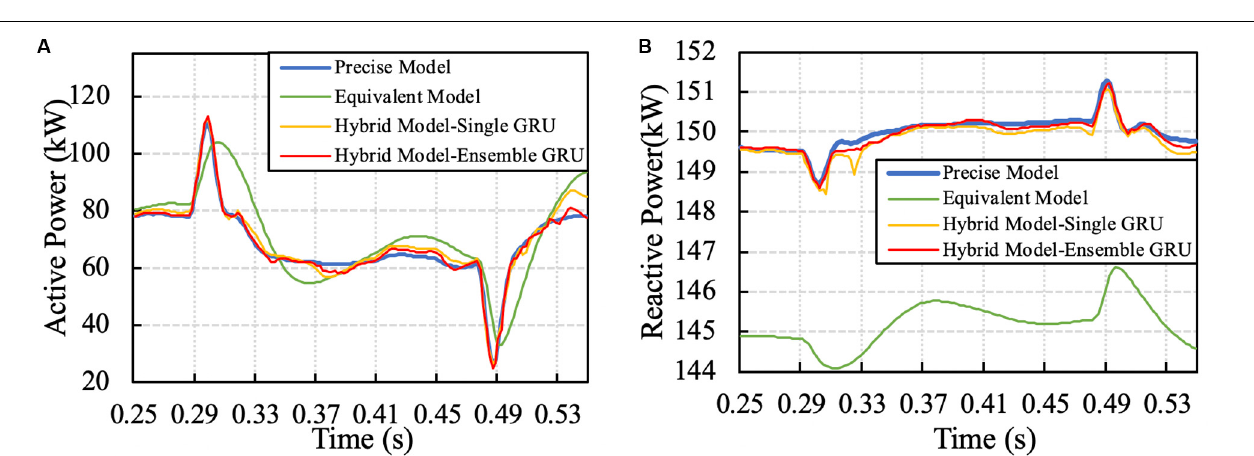
FIGURE 10 | Example of the response of precise, equivalent and hybrid model in Case III: (A) Active power, (B) Reactive